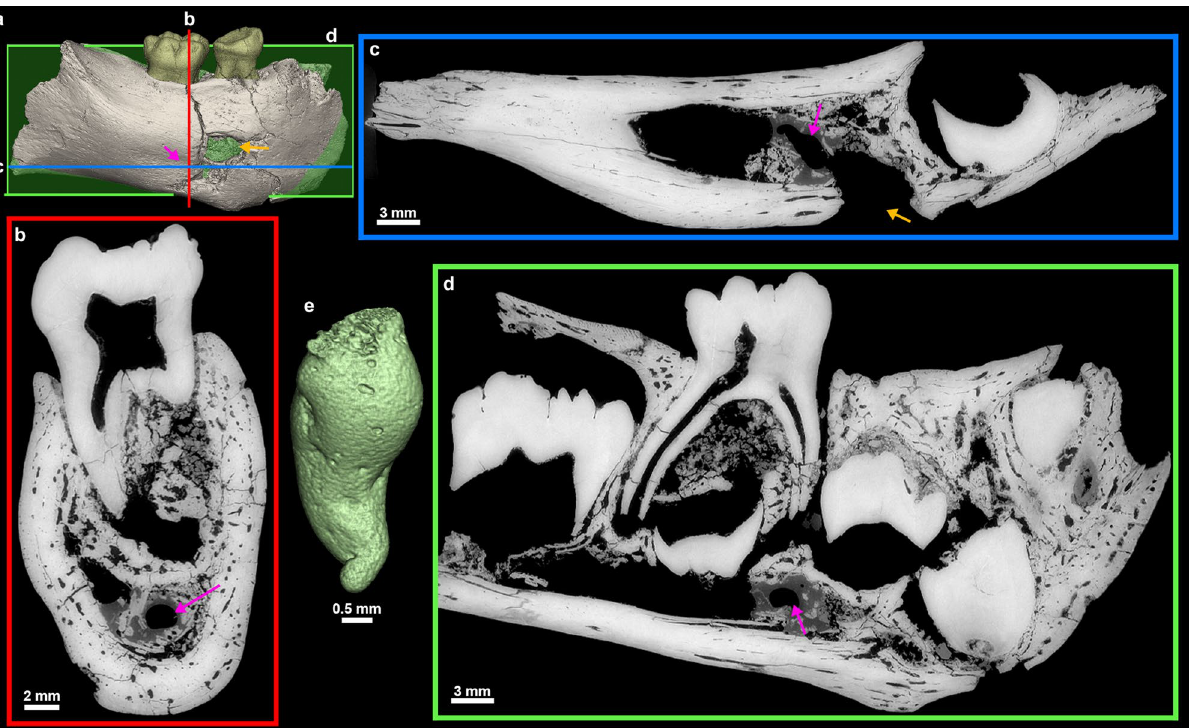
Figure 4. 3D model of the GAR IVE specimen ( a ), and frontal ( b , red), axial ( c , blue) and sagittal ( d , green) planes of section to illustrate the morphology of the hole (orange arrow) located in the area of the mental foramen. Its inner negative imprint shows a complex shape which is little compatible with the shape of a carnivore tooth ( c ). To note an additional convoluted shape represented in green in 3D (pink